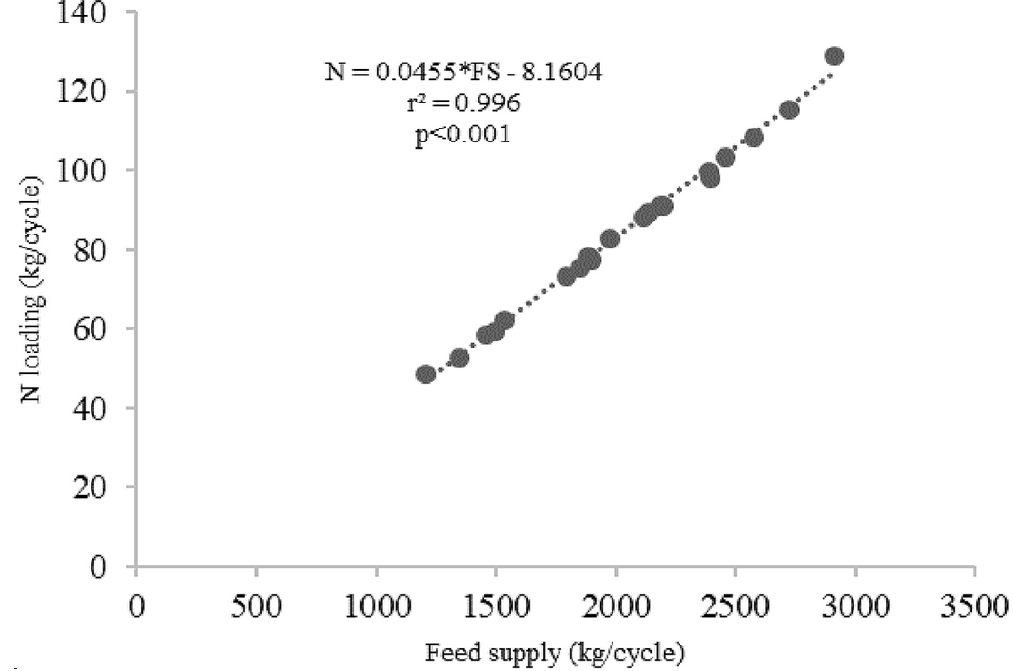
Figure 3. Feed supply and nitrogen loading relationship for giant gourami reared in floating cages.